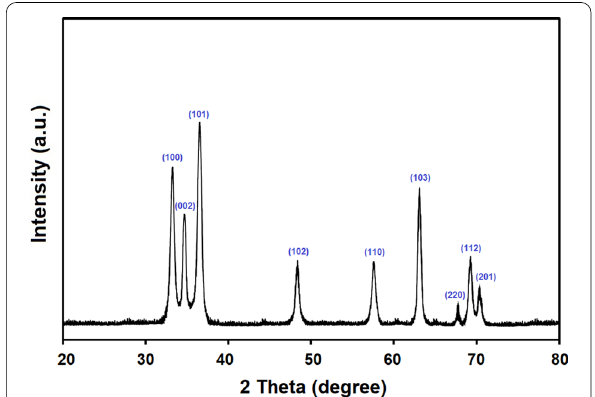
Fig. 1 X‑ray diffraction pattern (Cu Kα‑radiation) at room temperature of ZnONPs synthesized by the fungus A. tenuissima